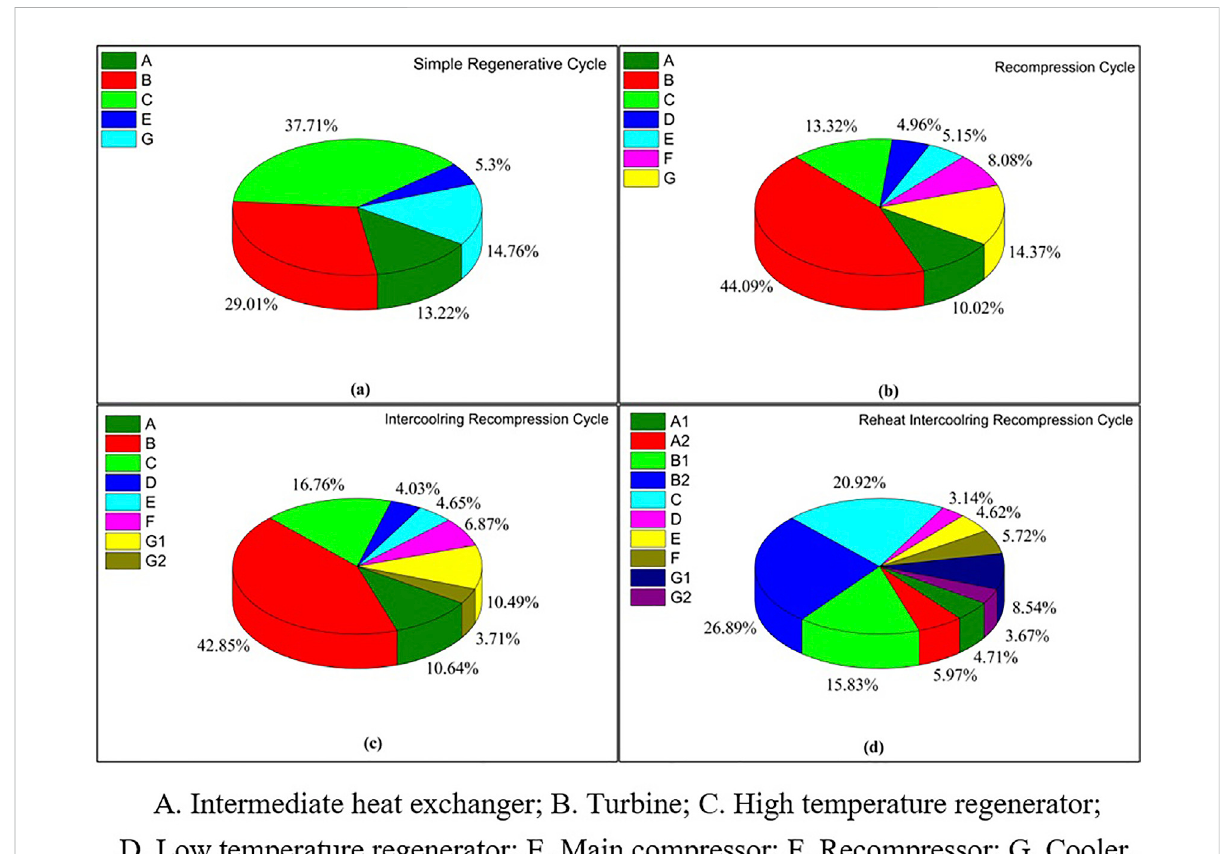
FIGURE 11 Exergy loss distribution of different cycle con fi gurations. (A) Simple Regenerative Cycle (B) Recompression Cycle (C) Intercooling Cycle (D) Reheat Intercooling Recompression